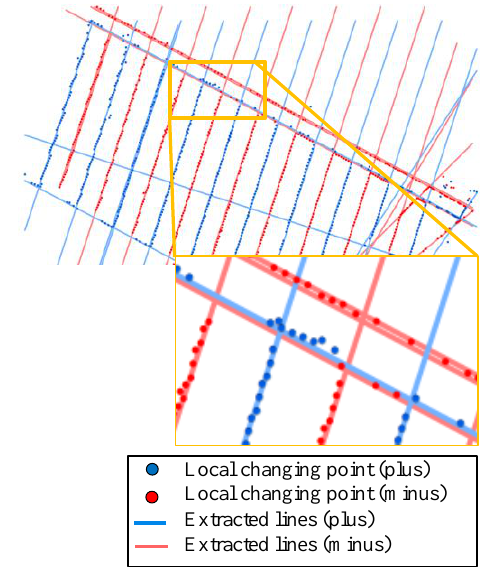
Figure 15. Result of traffic marking re-extraction with narrow area processing